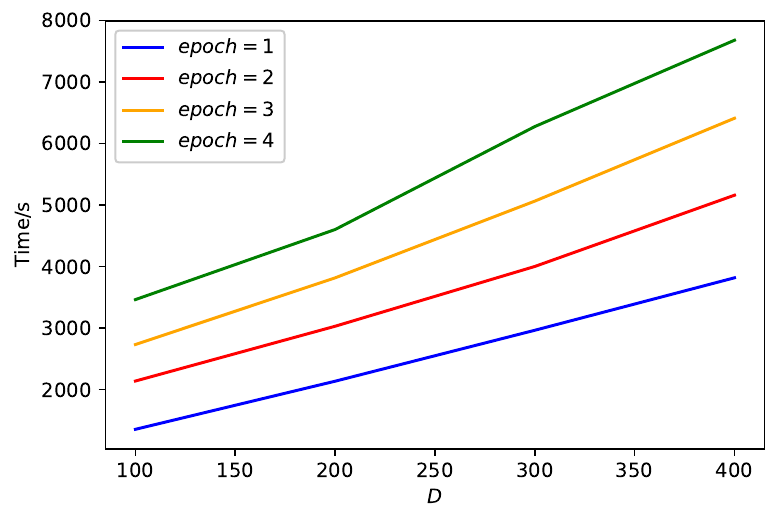
Figure 10. Time cost on stage one.